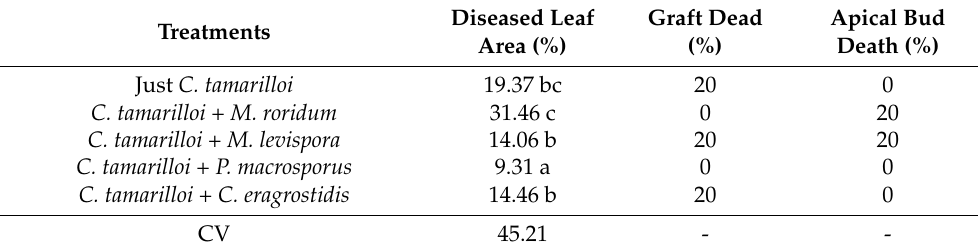
Table 1. Percentage of diseased leaf area, graft dead and apical bud death in seedlings after cura- tive treatment *.